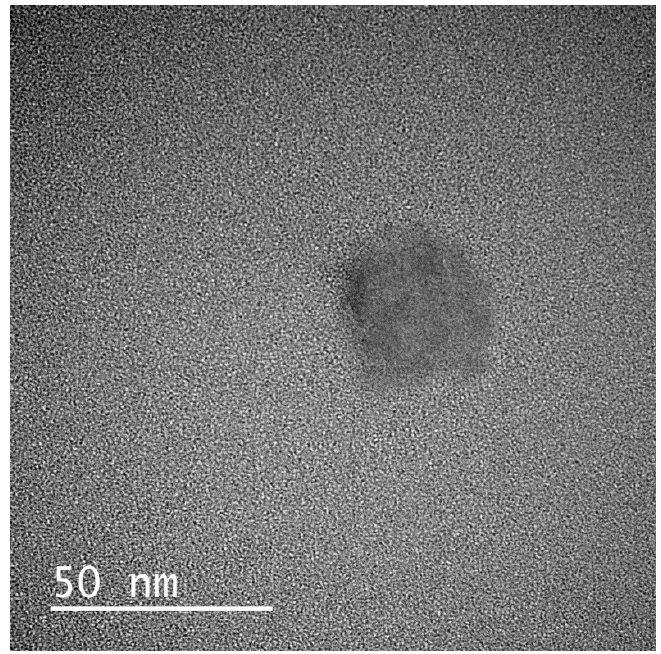
Figure 5. TEM image of the optimized SNEDDS formulation P5-40.